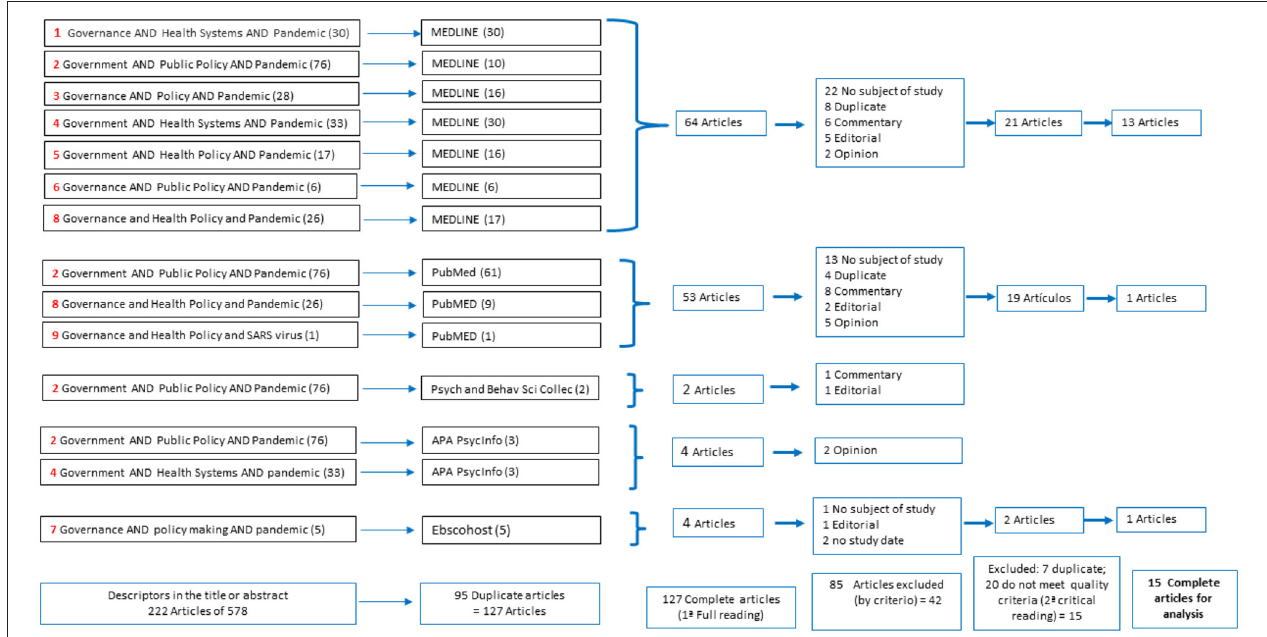
FIGURE 1 | Algorithm for searching the scientific literature of the systematic